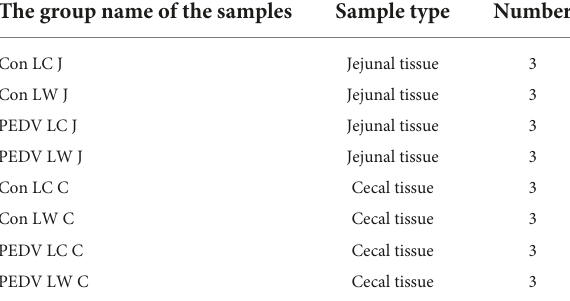
TABLE 3 The information of samples collected for microbiota